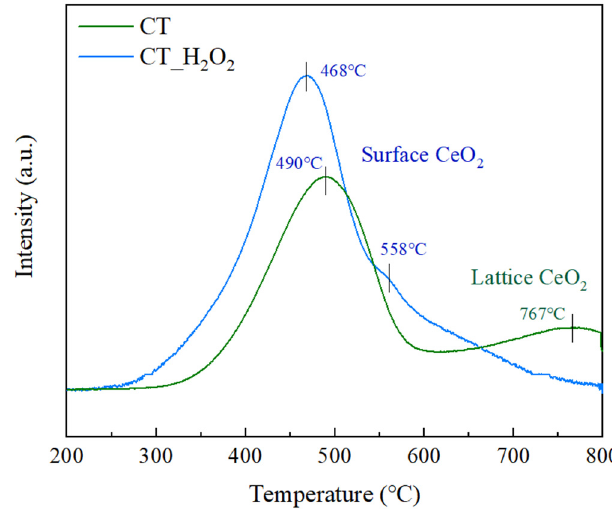
Figure 6. H 2 -TPR profiles of CT and CT_H 2 O 2 .